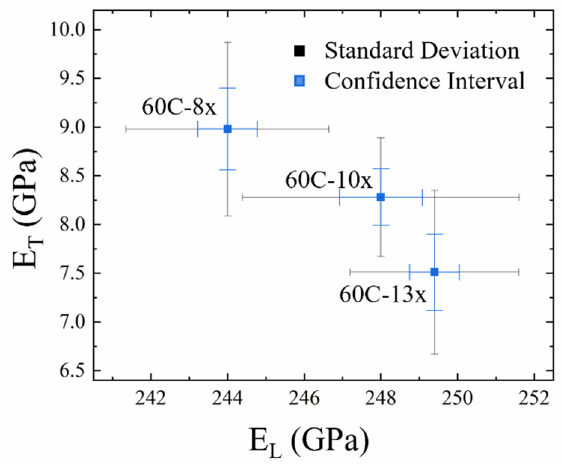
Figure 8. Relationship between E T and E L for the CFs measured in this study. The error bars represent the standard deviation (black) and 95% confidence intervals (blue).